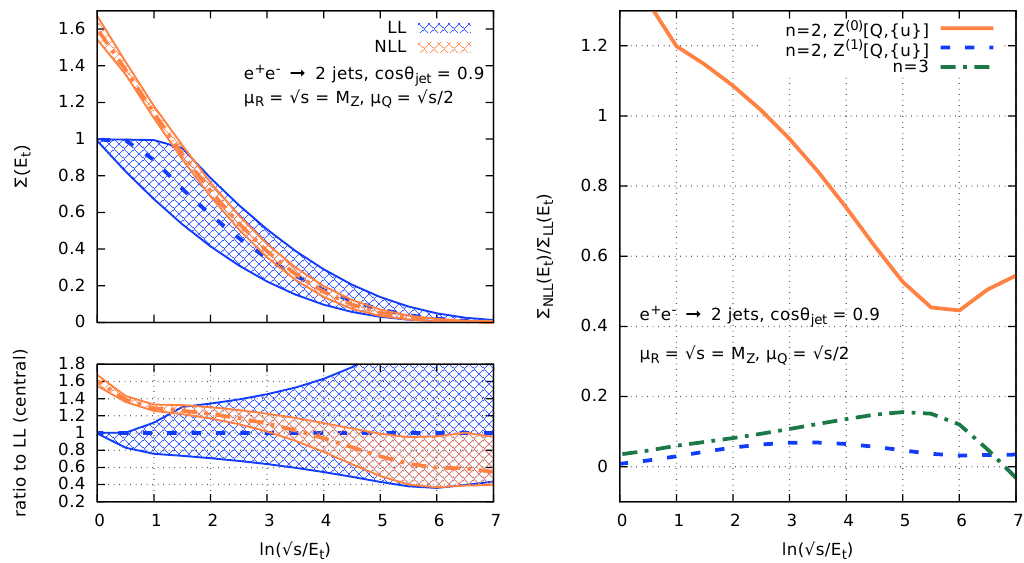
Figure 5 . Left: cumulative distribution Σ( E t ) for the transverse energy in the interjet rapidity gap at LL and NLL for c = 0 . 9 . Right: breakdown of the contributions to the NLL correction, relative to the LL